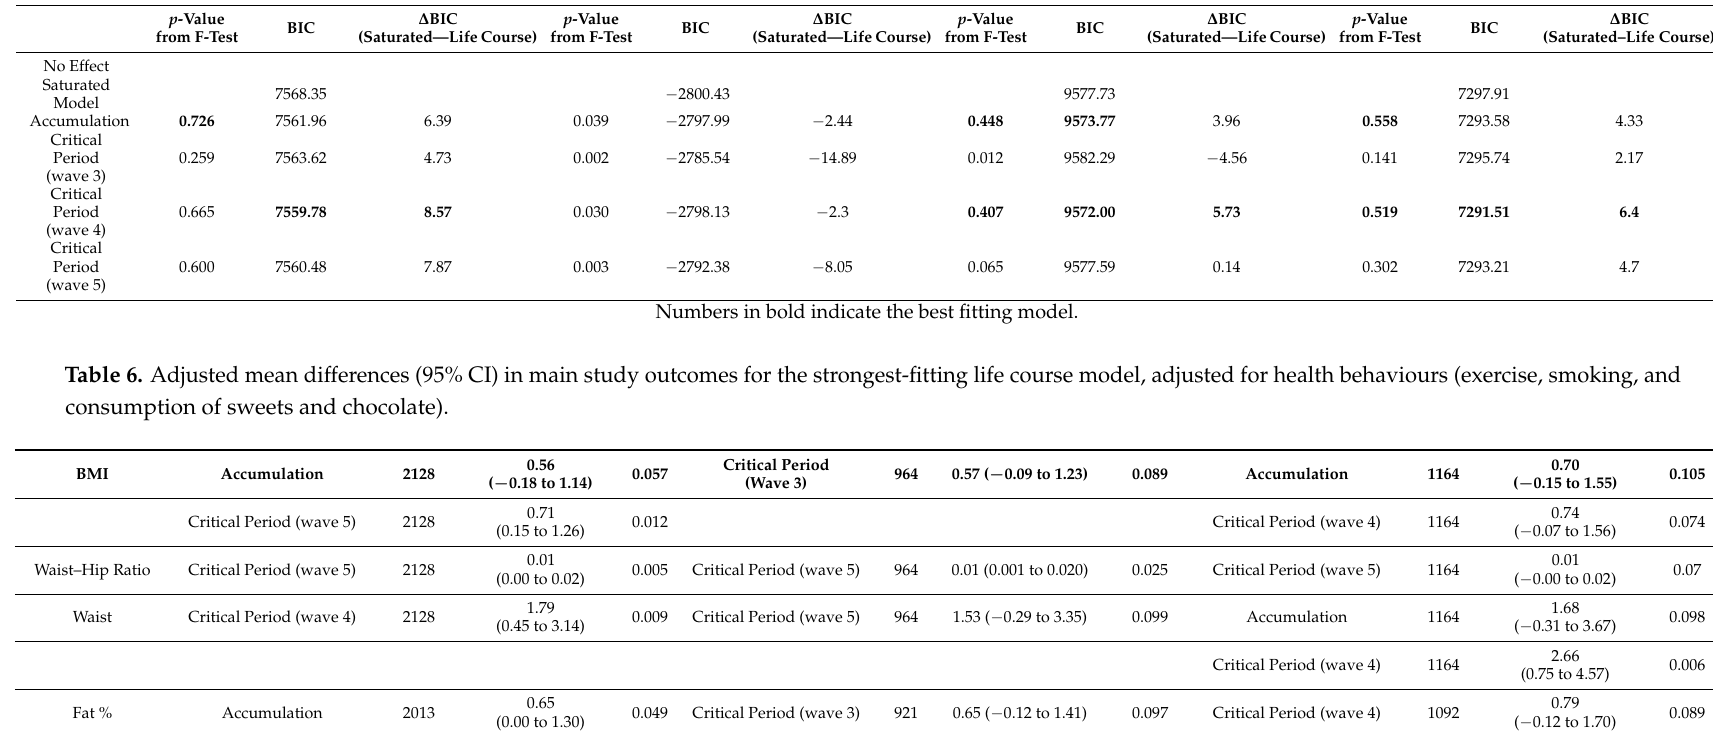
Table 5. p -Values and Bayesian Information Criterion to assess the selection of the life course model for the relationship of neighbourhood perceptions over time with BMI, waist–hip ratio, waist circumference, and fat percentage (WOMEN ONLY). BMI Waist–Hip Ratio Waist Fat % ∆ BIC p -Value p -Value from F-Test BIC (Saturated—LifeCourse) from F-Test BIC